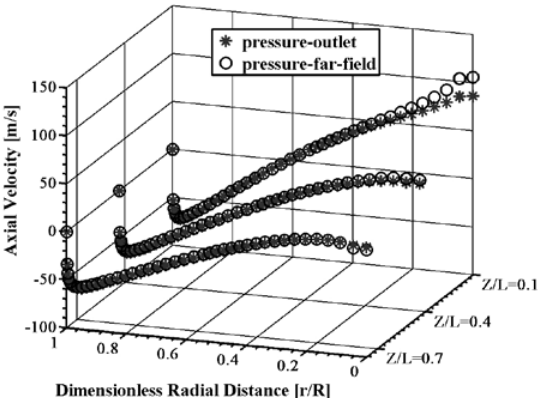
Fig. 10. Comparison of the tangential velocities at different longitudinal sections regarding two different boundary